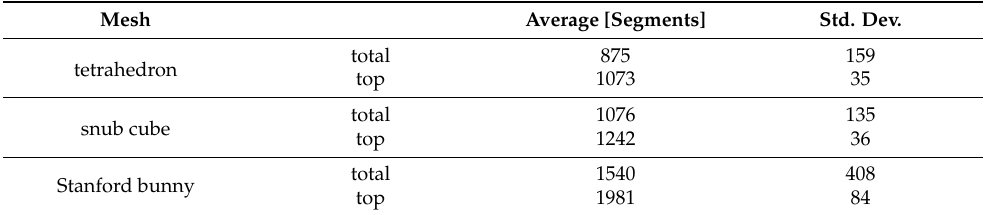
Table 2. Average and standard deviation of total number of helical segments for filling application.